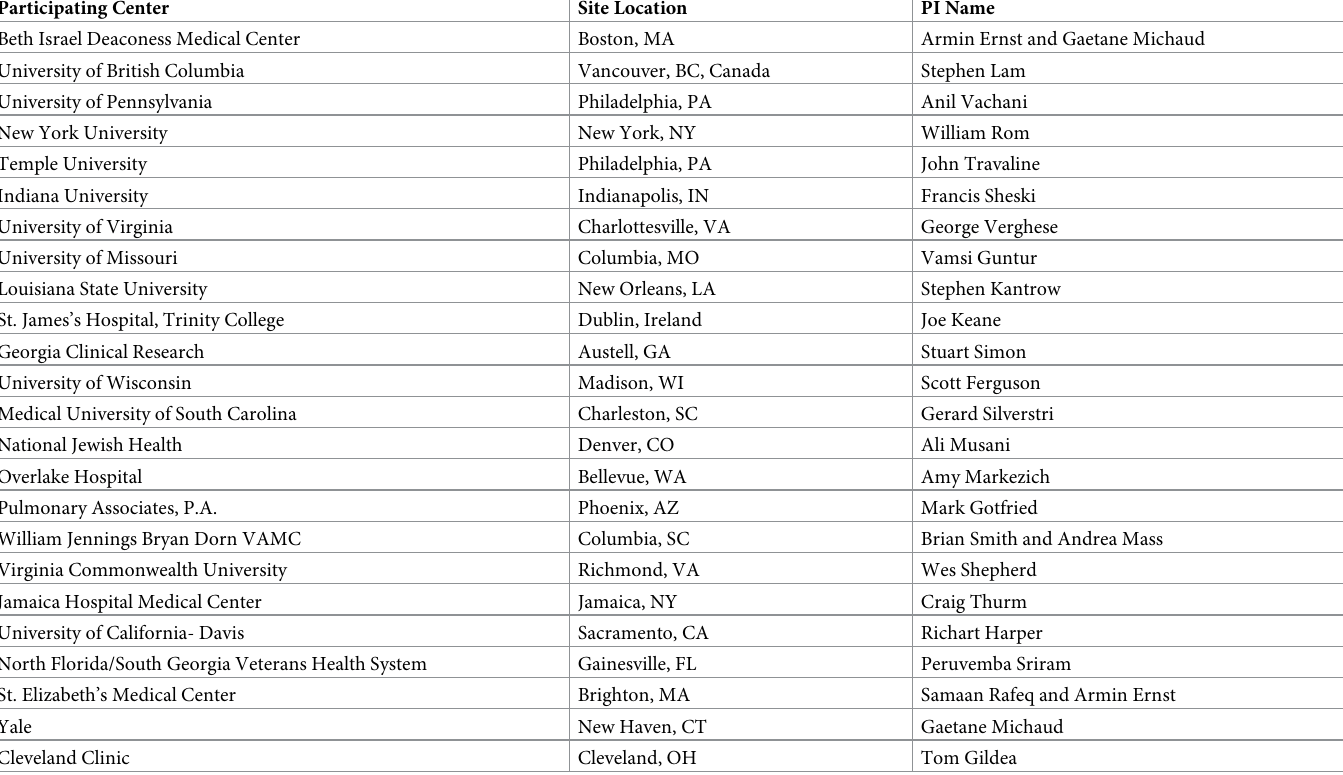
S6 Table. Total number of additional procedures performed in patients with up-classified intermediate and high risk lesions prior to malignant